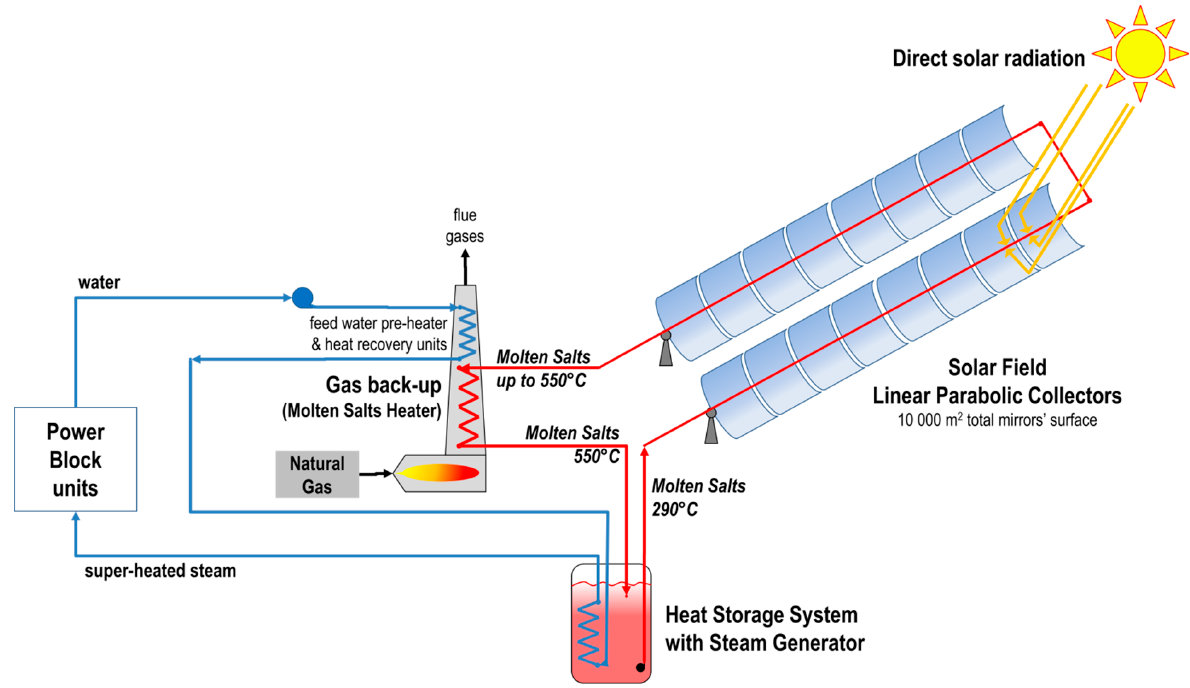
Figure 11. Layout of the molten salt loop in solar field of MATS plant [12].